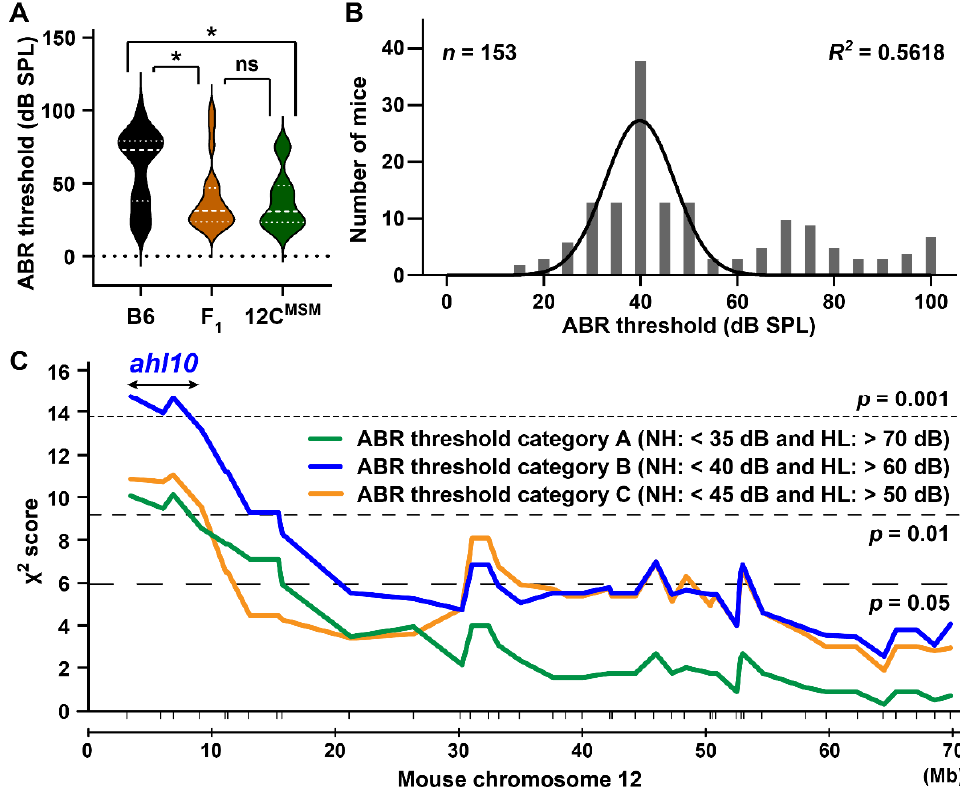
Figure 9. Identification of the genomic region ( ahl10 locus: double-headed arrow) associated with high-frequency hearing loss on chromosome 12: ( A ) Distributions of ABR thresholds at 32 kHz sound stimulus of the male B6 ( n = 20), (B6 × B6-Chr12C MSM ) F 1 ( n = 20), and B6-Chr12C MSM ( n = 18) mice at 4 months of age. The dashed and dotted lines within violin plots indicate the median and quartiles, respectively. Significant genotype effect (F 2, 55 = 5.9, p = 0.0048) of the ABR thresholds were detected by one-way ANOVA analysis. Results of Tukey’s multiple comparison tests are given (* p < 0.05 and ns, no significant difference). ( B ) Distributions of ABR thresholds at 32 kHz stimulus among the (B6 × B6-Chr12C MSM ) F 2 mice at 4 months of age. The best-fit curves for a Gaussian distribution are shown. The goodness of fit for the curve is given as R squared ( R 2 ), calculated by the GraphPad software. ( C ) A linkage map of the ahl10 locus (double-headed arrow), which is associated with resistance of the elevation of ABR thresholds at 32 kHz sound stimulus, using male (B6 × B6-Chr12C MSM ) F 2 mice at 4 months of age. The green (category A), blue (category B), and orange (category C) lines are χ 2 score plots, which are calculated from three category groups based on classifications of the normal hearing (category A, n = 37; B, n = 56; C, n = 76) and hearing loss (category A, n = 39; B, n = 49; C, n = 64) of ABR thresholds at 32 kHz stimulus and three genotypes (B6/B6, B6/MSM, and MSM/MSM) in F 2 mice. The marker positions (vertical bars; see Tables S1 and S3) are given below the linkage maps. The three horizontal dotted and dashed lines indicate statistically significant χ 2 scores.